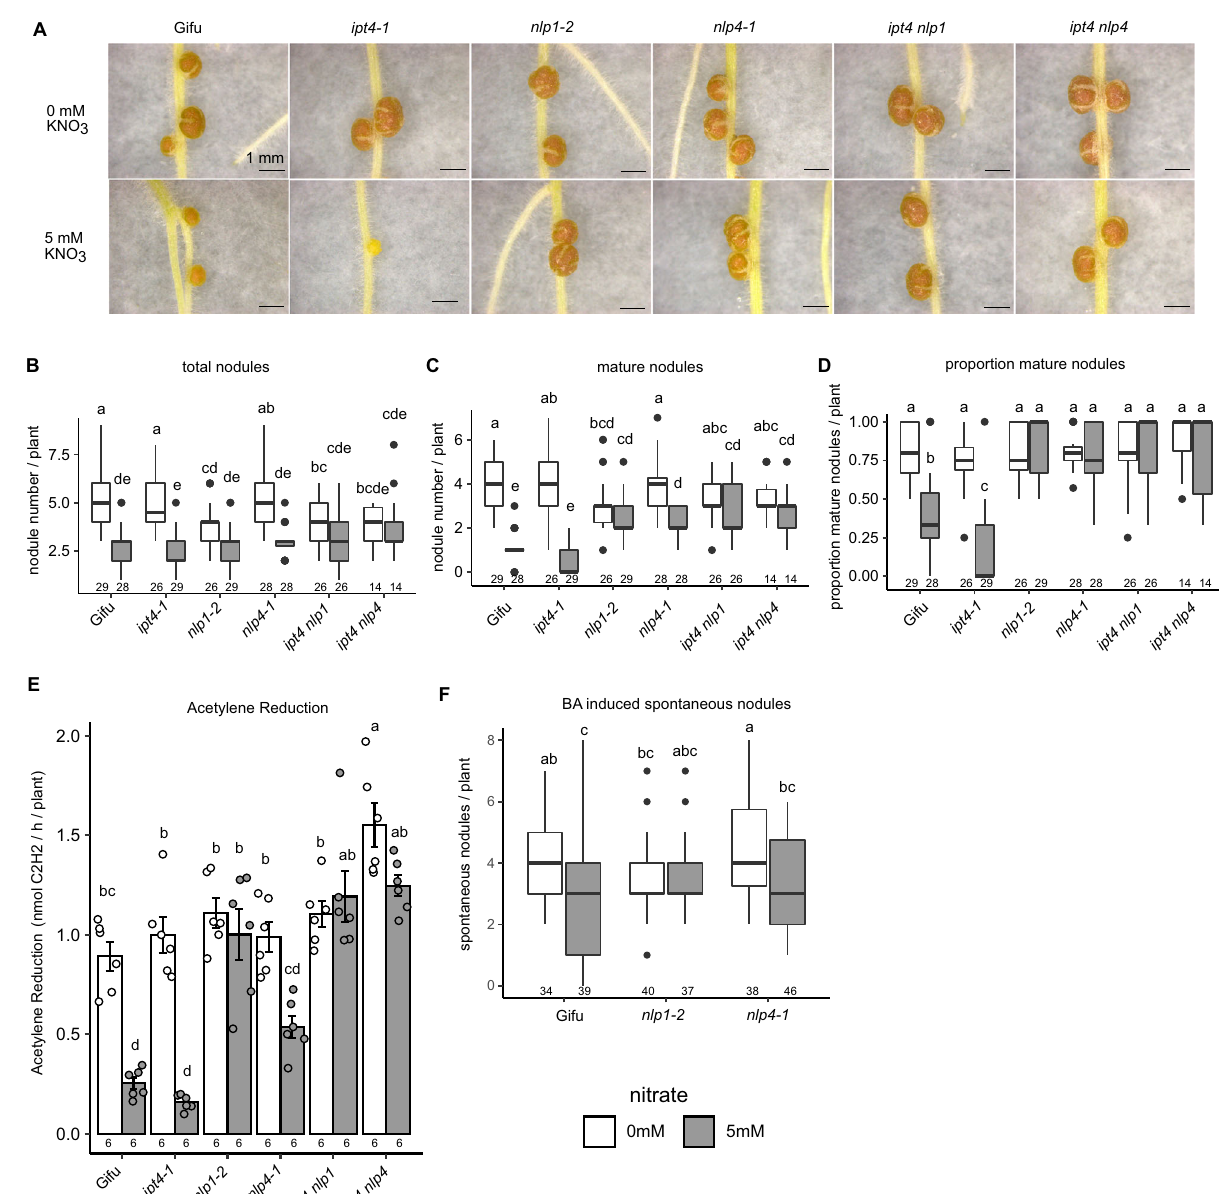
Fig. 7 Nitrate signalling mediated by Nlp1 and Nlp4 acts upstream of cytokinin biosynthesis to restrict symbiotic signalling. A Images of nodules developed in the absence and presence of 5 mM KNO 3 at 14 dpi with M. loti on the indicated host genotypes. Scale bar = 1 mm. B – D Development of total ( B ), mature ( C ), and proportion of mature nodules ( D ) in the absence and presence of 5 mM KNO 3 at 14 dpi with M. loti . E Nitrogenase activity assessed by ARA at 21 dpi with M. loti in the absence and presence of 5 mM KNO 3 . F Formation of spontaneous nodules in response to cytokinin (BA). Box plots show Min, Q1, Median, Q3, Max and outlier values in nodulation assays ( B – D , F ). Bars show mean ± SE. Signi fi cant differences among different genotypes and nutrient conditions are indicated by letters ( p < 0.05) as determined by ANOVA and Tukey post-hoc testing with pairwise P -values available in the Source Data fi le. The n values are shown below the respective